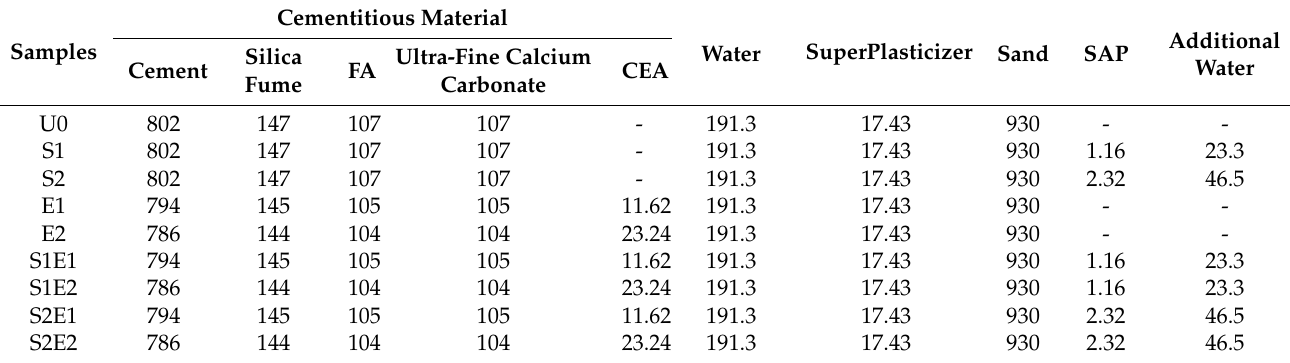
Table 4. Mix proportion of UHPC matrix (kg/m 3 ).